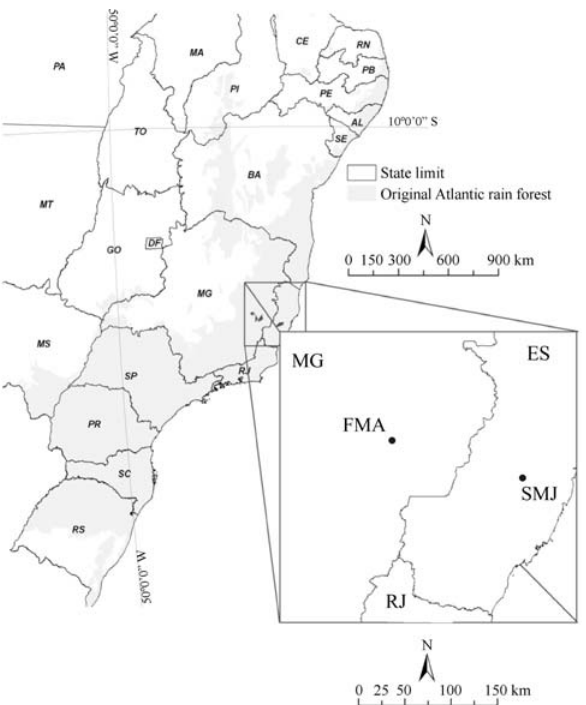
Figure 1 - Map depicting the easternmost portion of Brazil. Sampling sites of the Brachyteles hypoxanthus populations are highlighted. The FMA population in Minas Gerais (MG) state is roughly 150 km from the